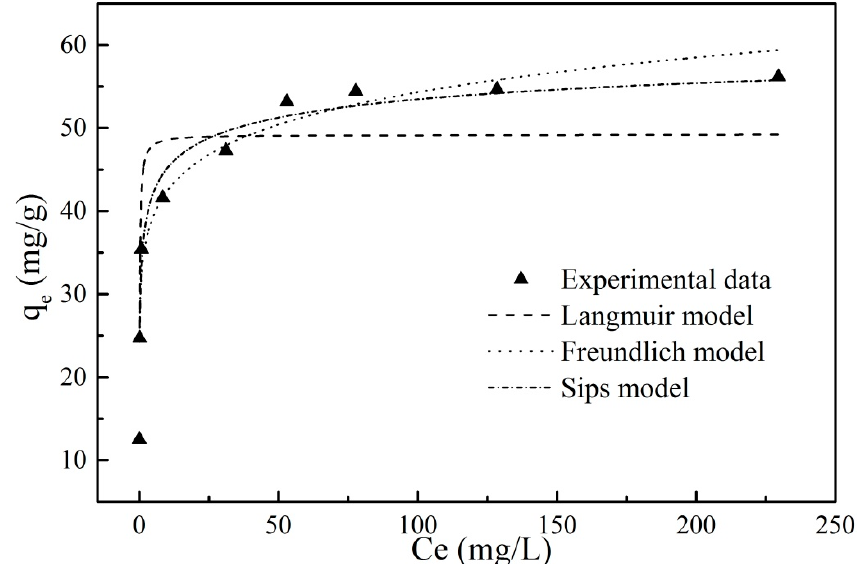
Figure 9. Langmuir, Freundlich, and Sips isotherm simulations for PRO onto GO / Fe 3 O 4 ( t = 24 h, V = 20 mL, m = 0.01 g, pH = 7.5).